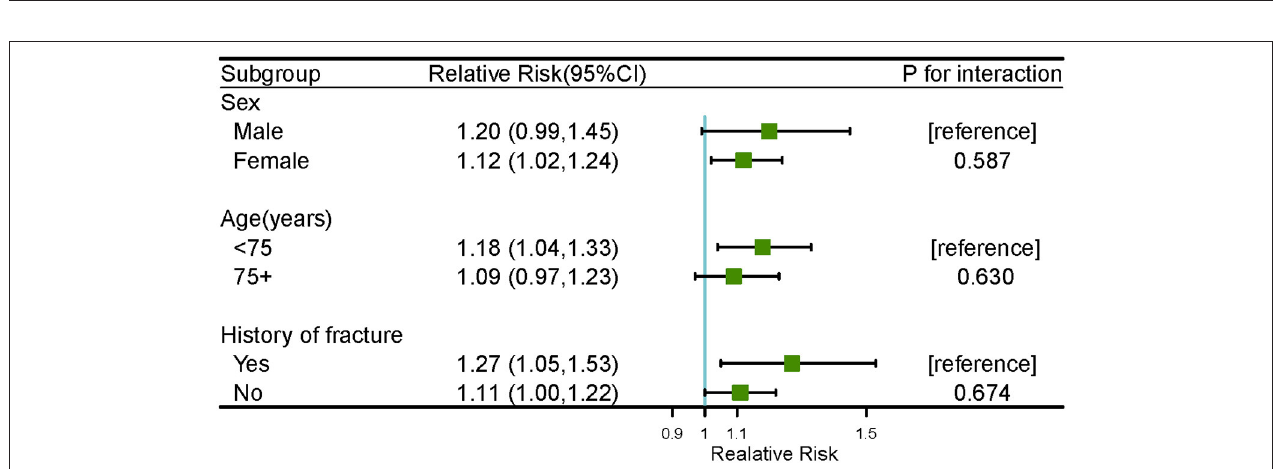
FIGURE 3 | The results of Z -test for cold effect ( − 2.0 vs. 25.8 ◦ C) on the number of hospitalizations for osteoporotic fractures within subgroup analyses at lag 2 day.